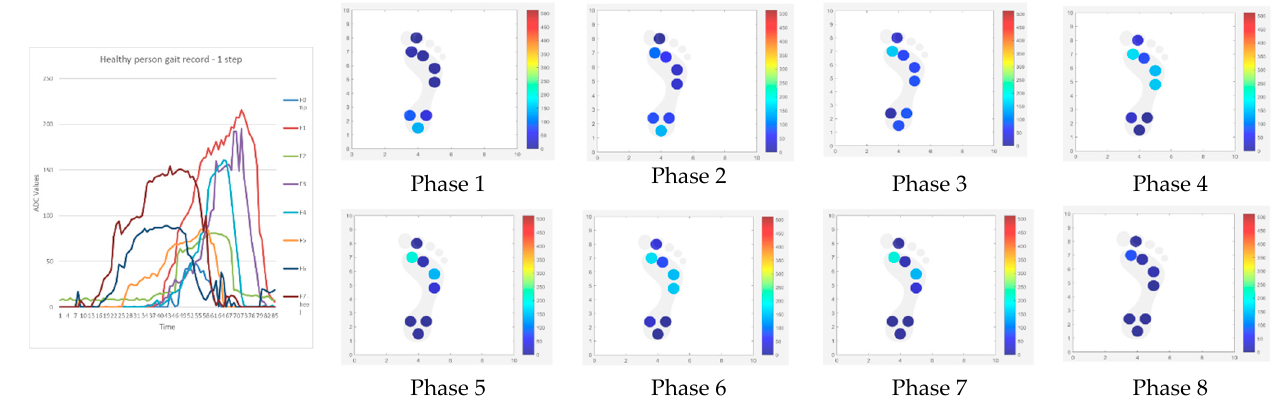
Figure 11. The eight ‐ step phases are recorded data for one step, healthy person gait, right foot, and loading on the sensorial elements.